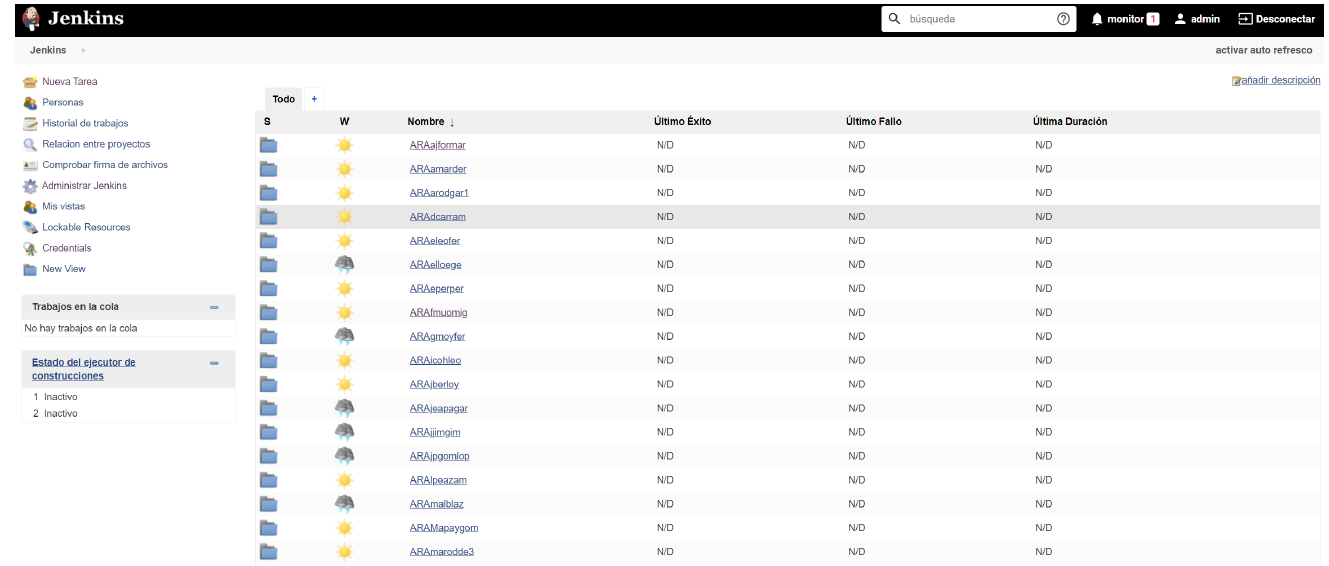
Figure 3. Jenkins view for the teacher with all created students